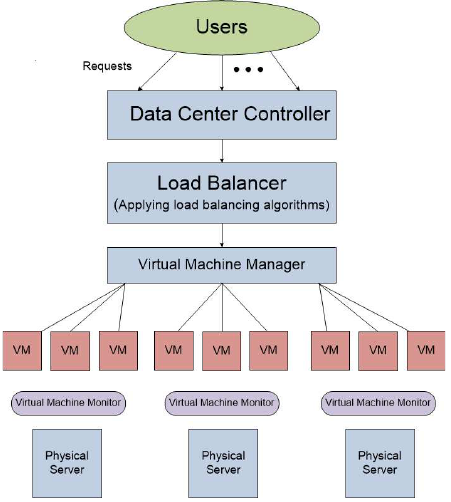
Figure 2. Load-Balancing Mechanism in Data Centers.